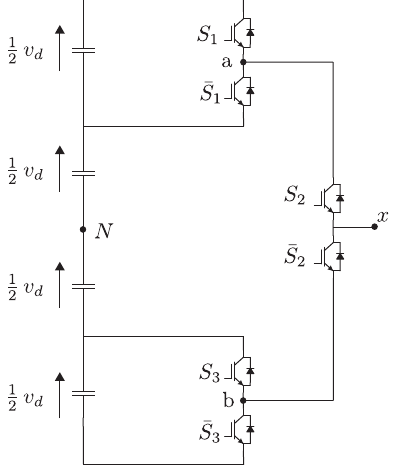
Figure 2. Four level quasi-nested (4L-QN) inverter topology